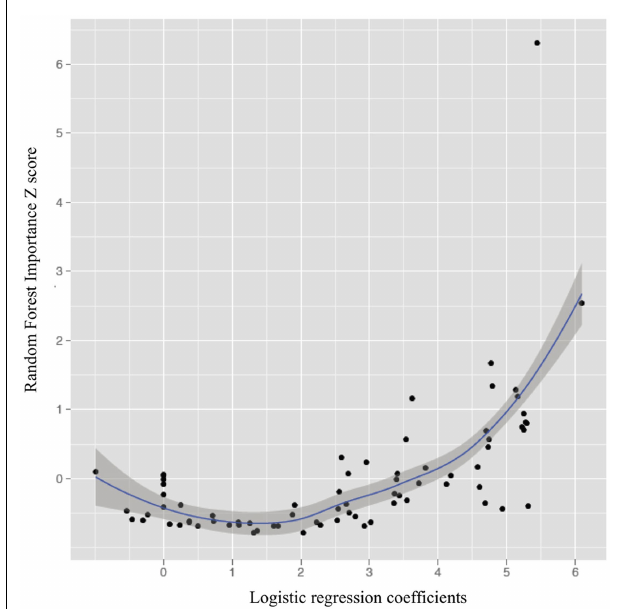
FIGURE 4 |The relationship between univariate logistic regression coefficients and Random Forest importance Z scores (importance score-mean importance score/ SD importance scores; loess line in blue with 95% confidence